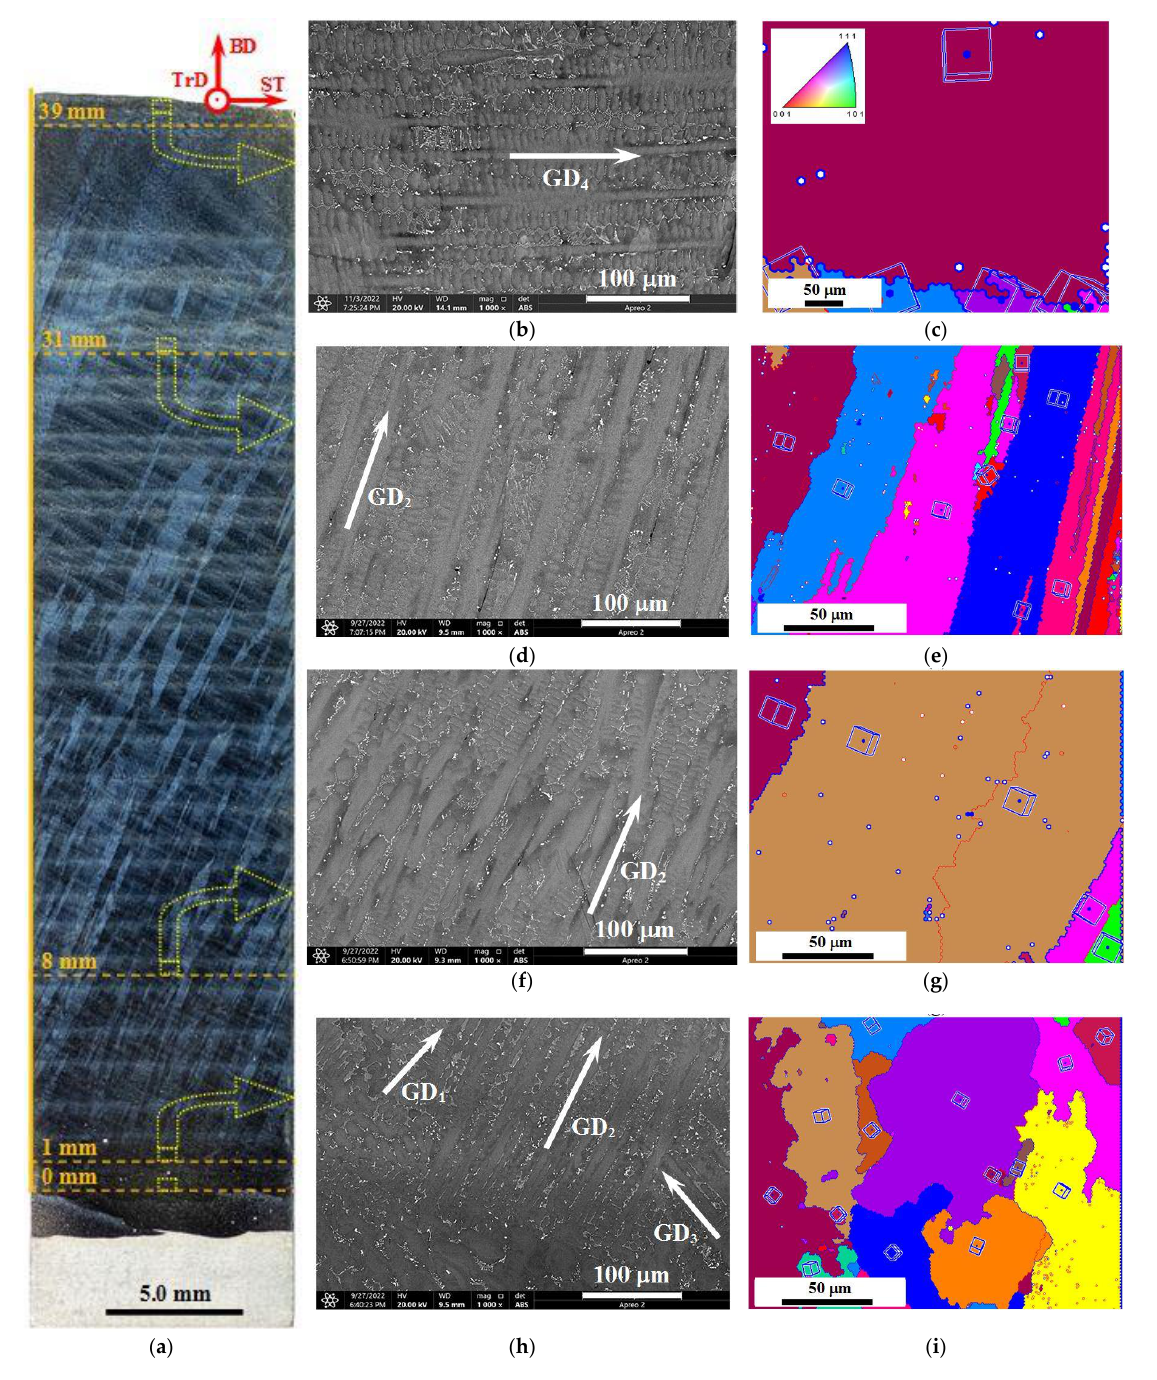
Figure 3. Macro- ( a ), microstructure ( b , d , f , h ), and EBSD maps ( c , e , g , i ) of material of products obtained via wire-feed electron beam additive manufacturing at a distance from the substrate of: 39 mm (in the final layer) — ( b , c ); 31 mm — ( d , e ); 8 mm — ( f , g ); 1 mm (in the transition layer) — ( h , i ). BD — building direction, ST — scanning trajectory, TrD — transverse direction, GDi — direction of dendrite growth. The closed dashed lines show the localization of the areas subjected to detailed studies by means of SEM and